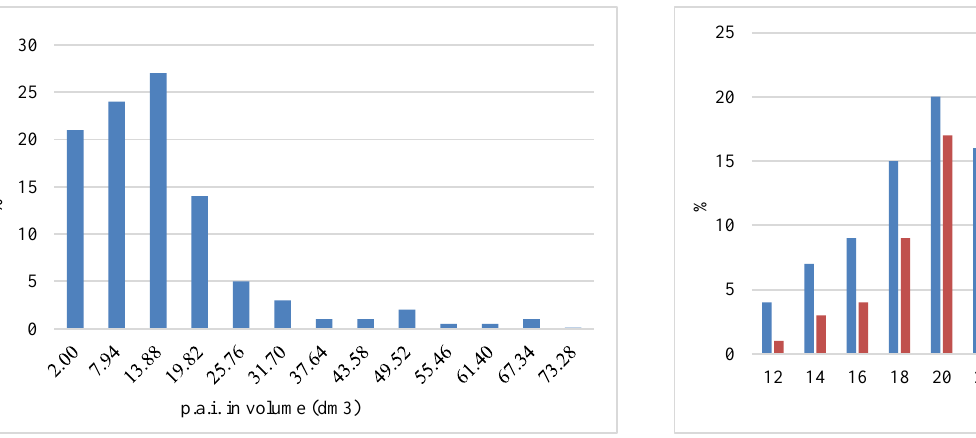
Figure 3. Frequency distribution of stem number per hectare (ha) and the periodic current increment in volume between 10 and 27 ages in the function of breast height diameter (dbh) groups (Pusztavacs 215